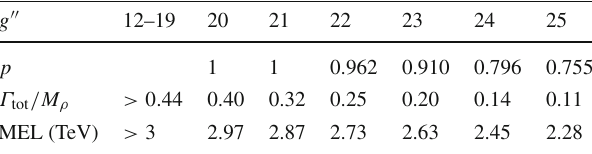
a The mass is also not excluded within ( 1 . 11 ; 1 . 30 ) TeV b The mass is also not excluded within ( 1 . 03 ; 1 . 30 ) TeV Table 8 The updated smallest tBESS resonance mass exclusion limits (MEL) within the interval 0 ≤ p ≤ 1 assuming b L = 0 and b R = 0 . 1 forvariousvaluesof g (cid:2)(cid:2) .Thesecondandthirdrowscontain,respectively, thevaluesof p andoftheresonancefatnessthatcorrespondtothequoted mass exclusion limit g